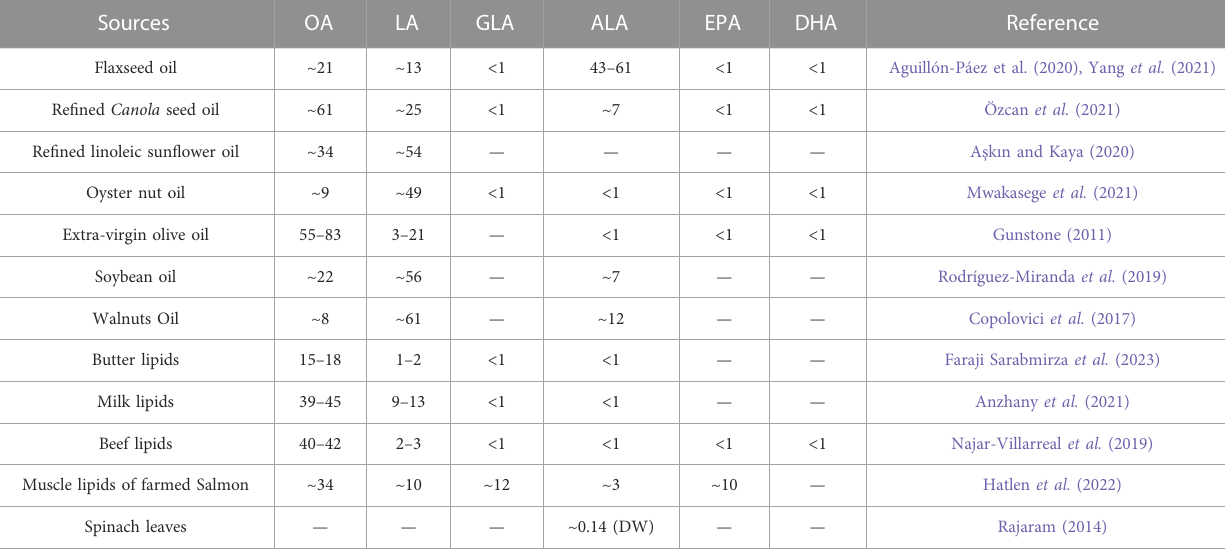
Spinach leaves DW, dry weight.